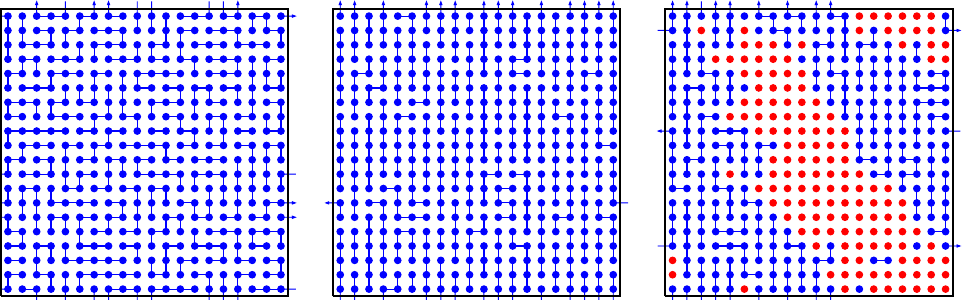
Figure 3. Chain morphologies on a two-dimensional 20 length of six monomers. Single material with Gaussian chains η = 0 (left), worm-like chains with preferred orientation η = 0.9 (middle) and chains in a BHJ where only the blue material is a polymer and the red material is small molecules